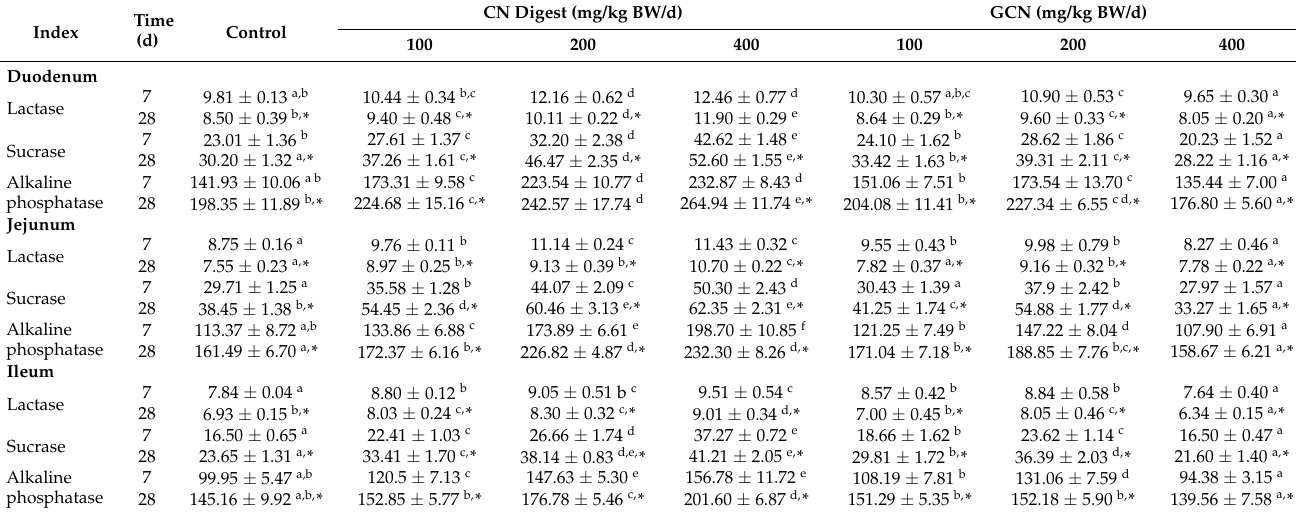
Values are reported as means ± standard deviations ( n = 6), while different lowercase letters after the values as the superscripts in the same row indicate that one-way ANOVA of the means differs significantly ( p < 0.05). Paired samples t test is used to determine the differences of the same enzyme activity between 7 and 28 d, while the asterisk indicates data difference ( p < 0.05). 1 Both lactase and sucrase activities are expressed as nmol glucose/(mg protein min), whereas alkaline phosphatase activity is expressed as U/mg